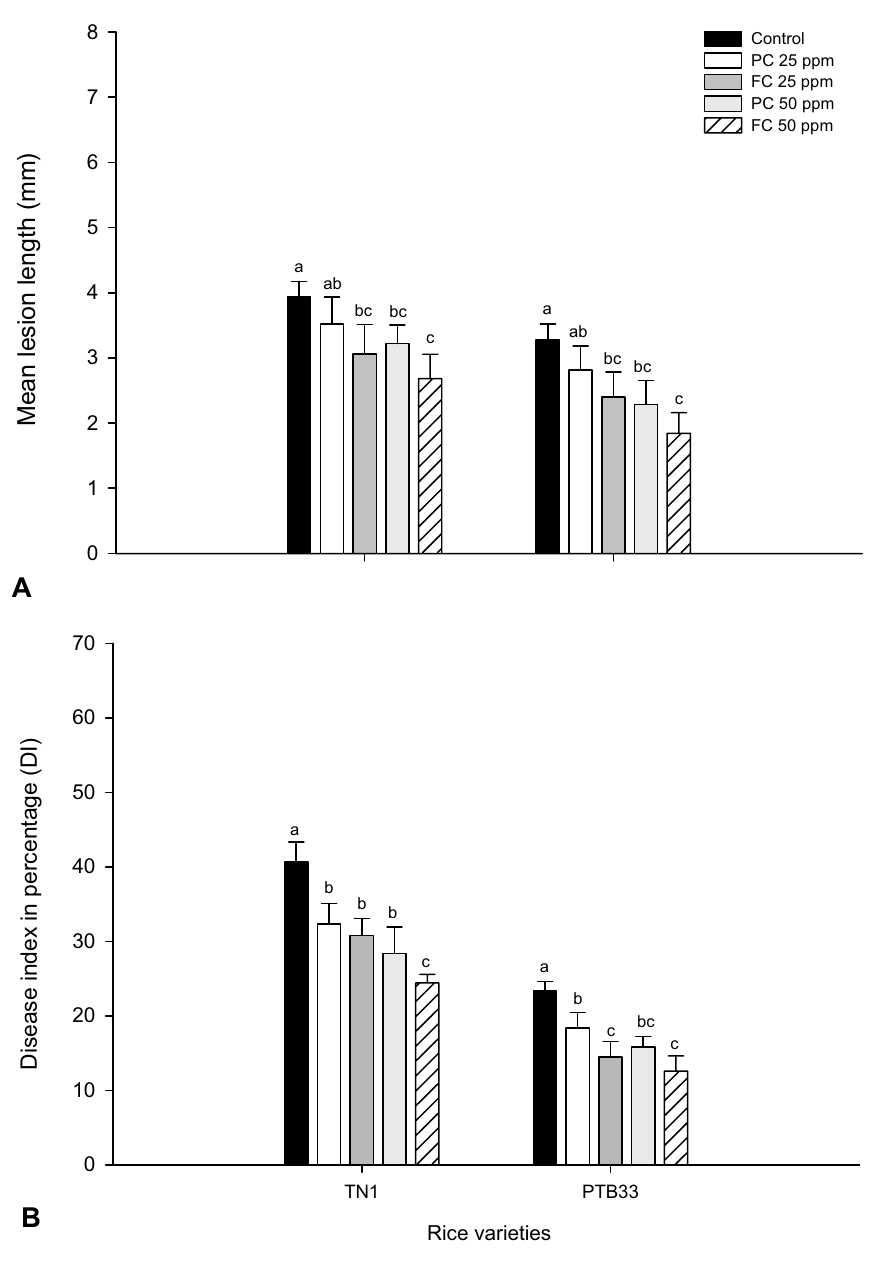
Figure 8. Mean lesion length (cm) ( A ) and disease index ( B ) of Xoo after treatment with fungal (FC) and product chitosan (PC) (± SEM with five replication) (with in the bars denoted by a different letter are significantly different at P ≤